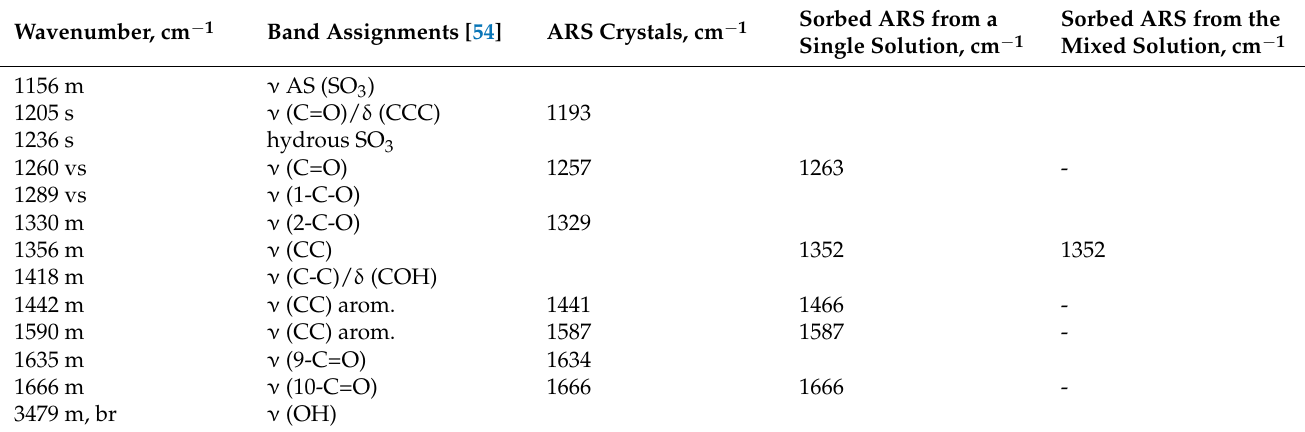
Table 3. Band assignment for ARS crystal and ARS after being sorbed on the HNC.